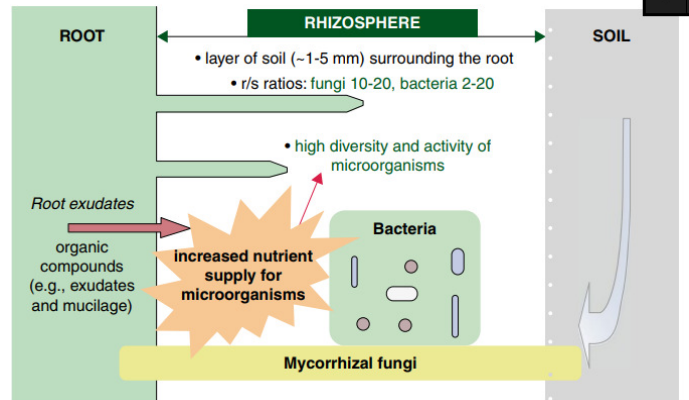
Figure 4. Rhizosphere microorganisms as a critical link between plants and soil (Adapted from Richardson et al. ,